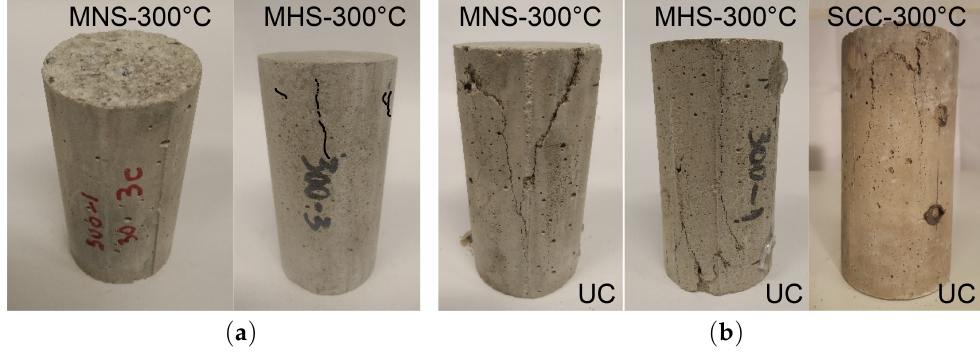
Figure 16. Images of specimens after exposure to 300 ◦ C—( a ) On the left side: MNS and MHS after thermal treatment, and ( b ) On the right side: after UC tests on MNS, MHS and SCC